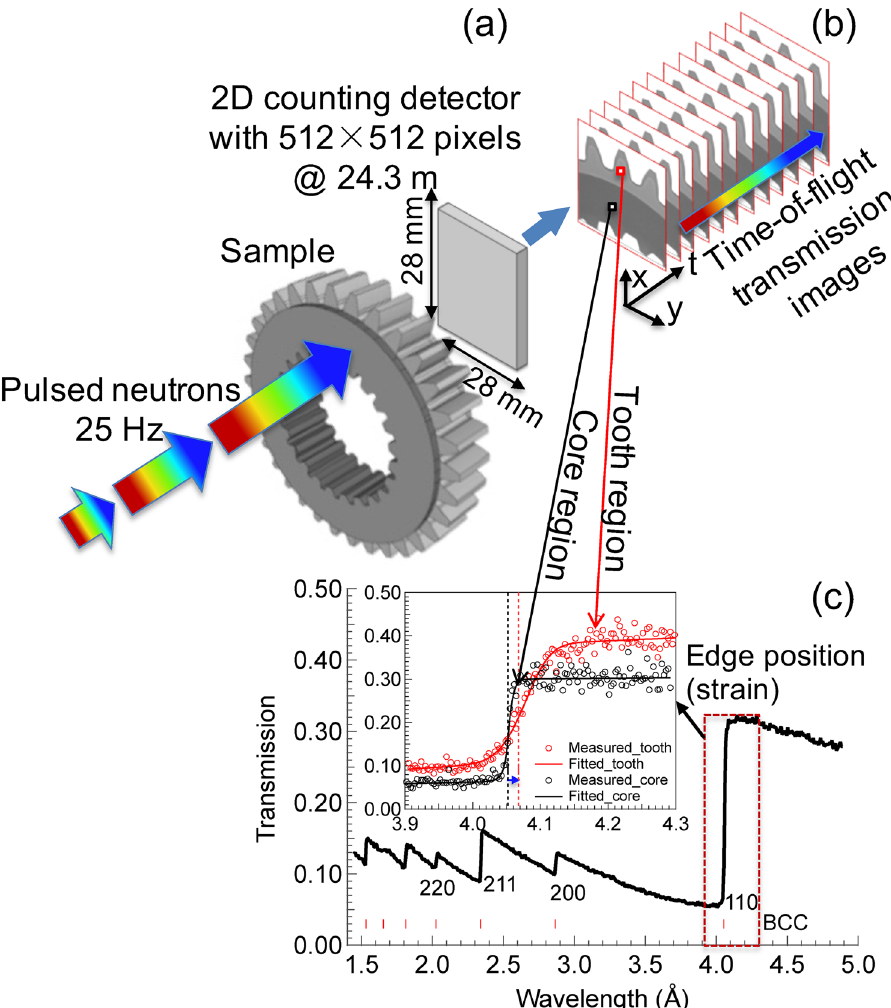
Figure 1. Schematic of the neutron Bragg-edge transmission imaging method: ( a ) Bragg-edge imaging experiment setup on the pulsed source; ( b ) the obtained energy-resolved neutron transmission images; and ( c